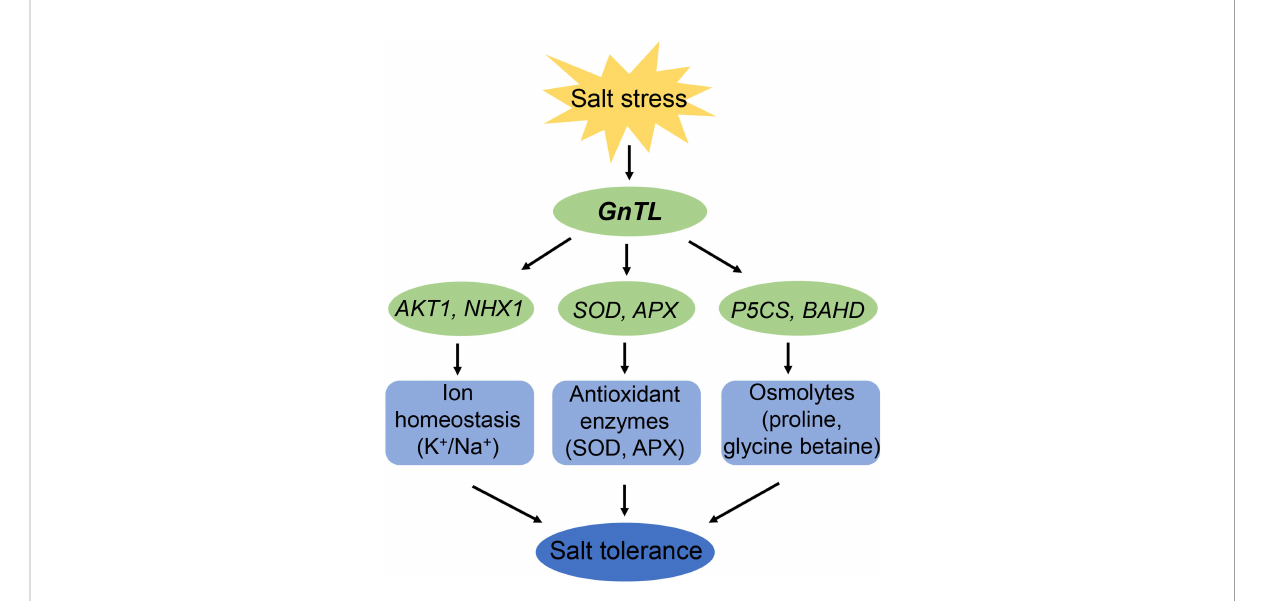
FIGURE 11 Proposed model for functional process of GnTL in improving plant salt